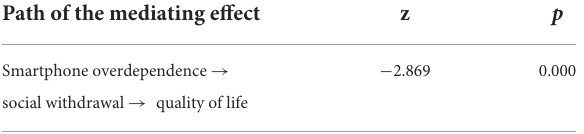
TABLE 7 Verification of the significance of the